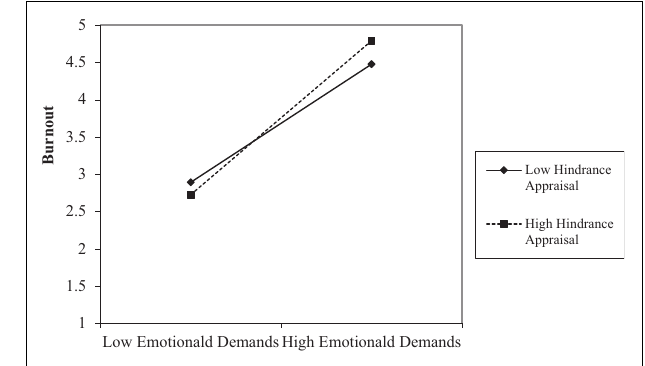
FIGURE 1 | The interaction between time urgency and challenge appraisal on engagement in Study 1.